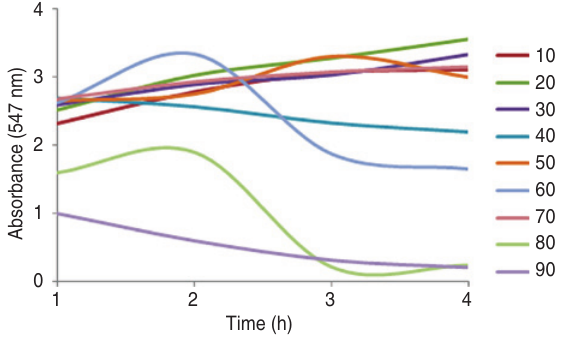
Figure 3: The effect of temperature on the synthesis of gold nano- particles using quail egg